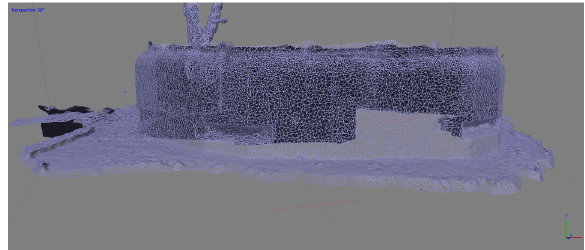
Figure 13. TIN model of pillbox № 428